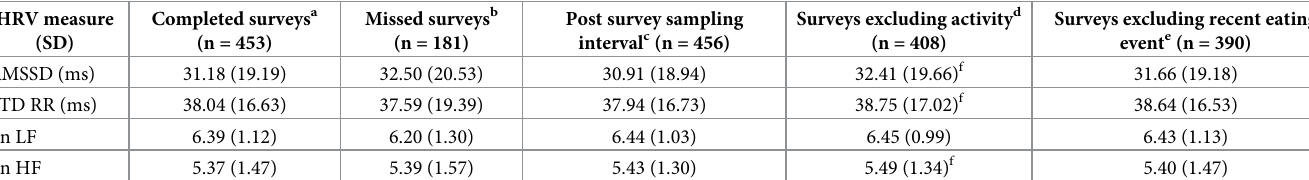
below the group mean. A smaller percentage had mean HRV differences > 2 SD above the group mean, ranging from 12.1% for RMSSD to 18.2% for ln HF. Mean differences were in